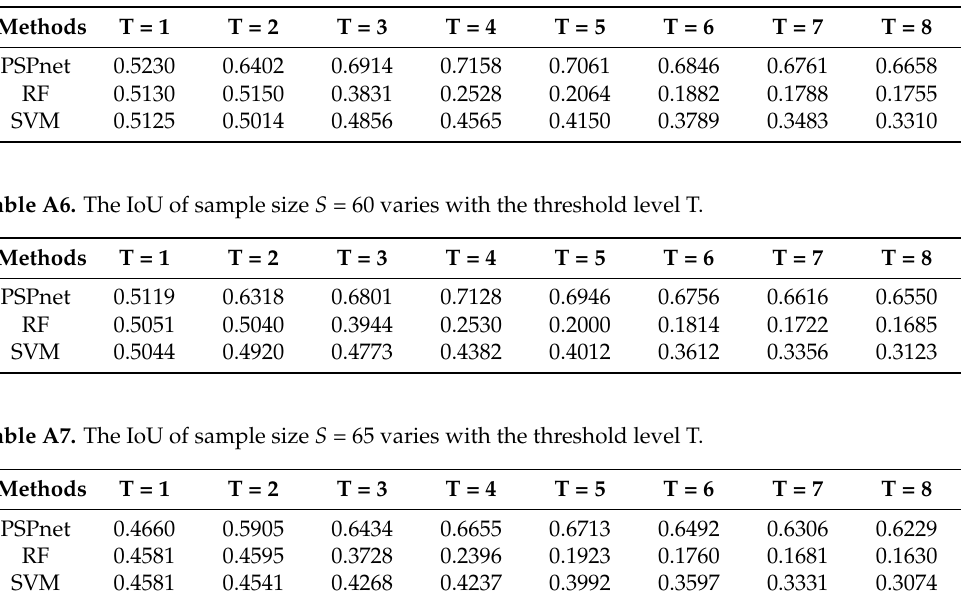
Table A5. The IoU of sample size S = 55 varies with the threshold level T.